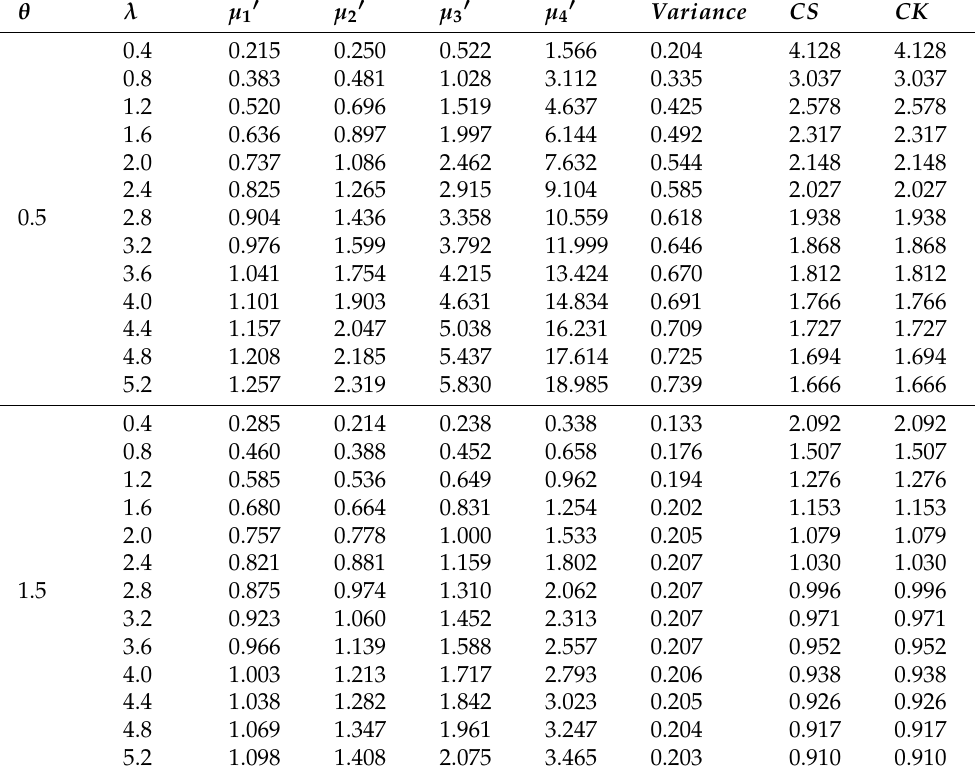
Table 2. Moments for TLMW distribution at α = β =